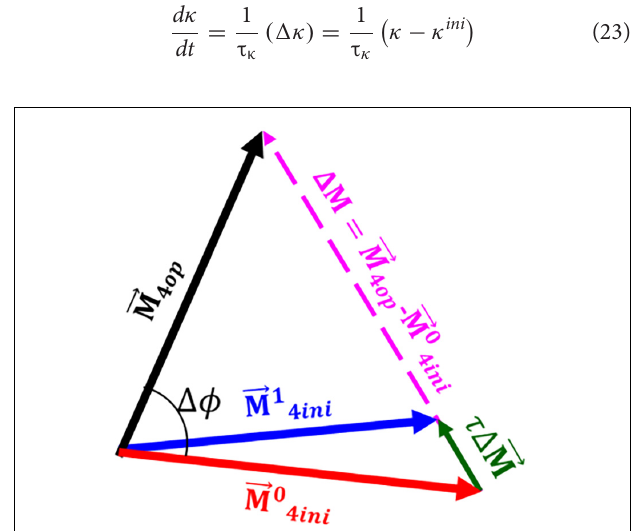
FIGURE 6 | A schematic presentation of the remodelling process. Once the vector representing the optimum direction of the fibres was calculated ( a fraction of the total difference between the optimum fibre configuration and −→ the initial configuration ( τ (cid:49) M ) was added to the initial configuration of the −→ fibres ( M 0 4 ini ) resulting in the initial configuration for the next iteration of the −→ 1 ) . In this figure, (cid:49) φ indicates the angle between remodelling process ( M 4 ini the optimum fibre direction and initial direction of